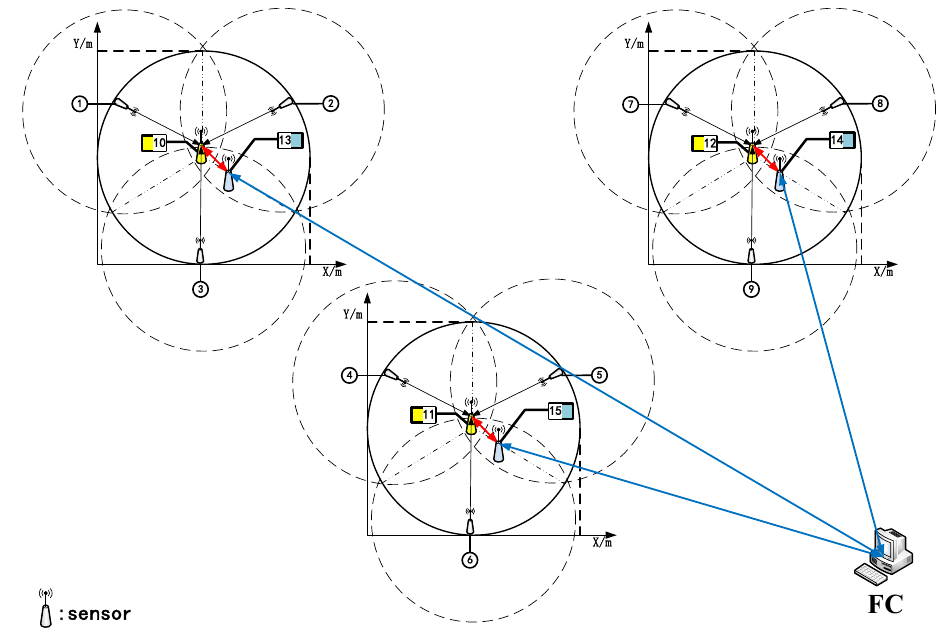
Figure 9. Clustering distributed sensor network (FC: Fusion center).